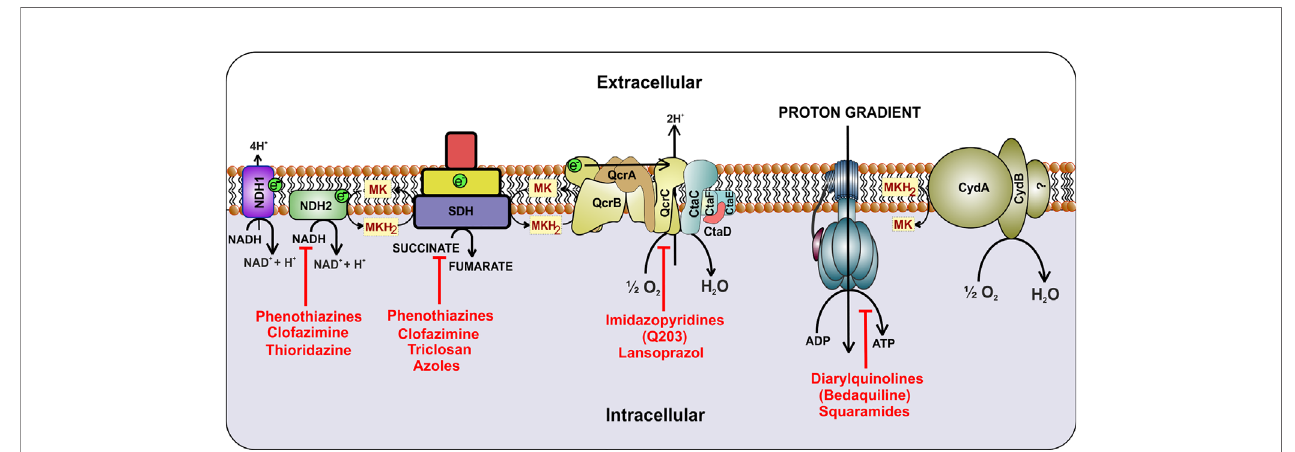
FIGURE 1 | Schematic representation of the electron transport chain of mycobacteria. NADH dehydrogenase (Complex I) oxidizes NADH and transfers the electrons to cytochrome bc 1 -aa 3 oxidoreductase (complex III-IV) by reducing menaquinone. Alternatively, succinate dehydrogenase (complex II) uses succinate as substrate and transfers electrons to complex III via menaquinone. Electrons are then transferred to cytochrome bc 1 -aa 3 and cytochrome bd -type menaquinol oxidase ( bd oxidase), which fi nally passes the electrons to the terminal electron acceptor, oxygen. During this process, a proton gradient is generated, which helps in the synthesis of ATP by ATP synthase. Inhibitors of the respiratory complexes are shown in red